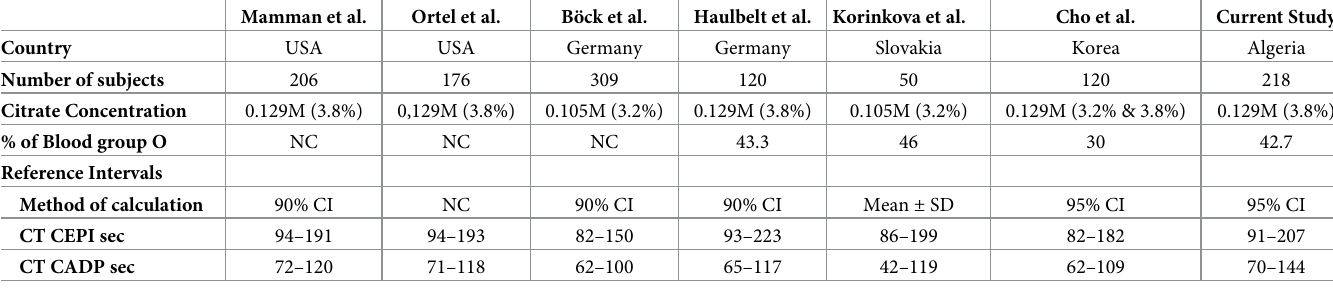
Table 4. Reference intervals of PFA-100 closure times from six reports that studied large numbers of healthy individuals. Mamman et